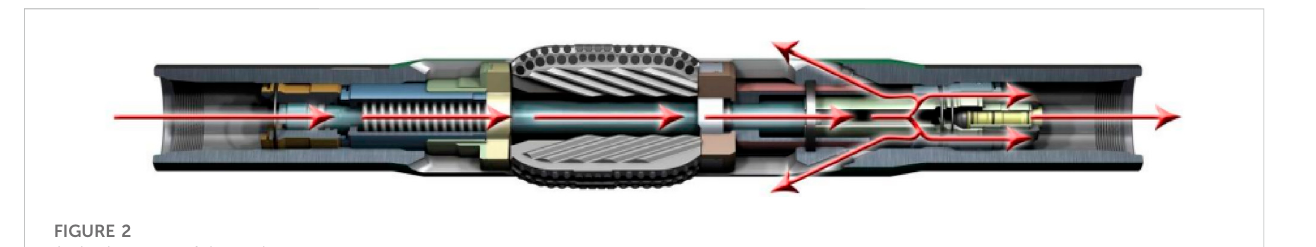
FIGURE 2 Activation state of the